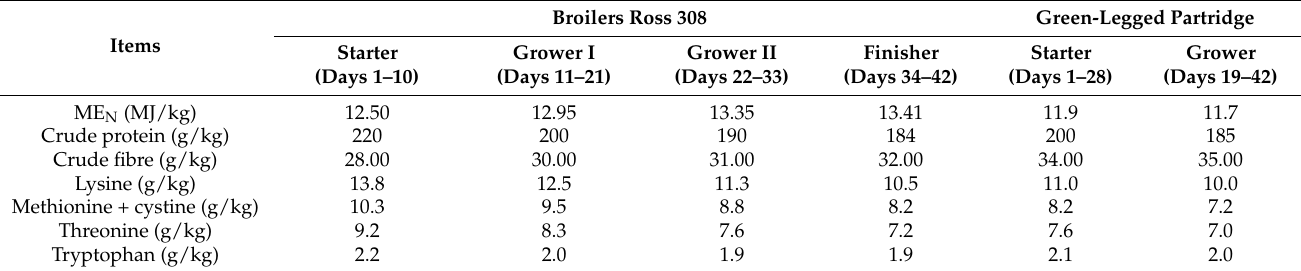
Table 1. Chemical composition of commercial feeds used for chicken broilers and green-legged partridge chickens.